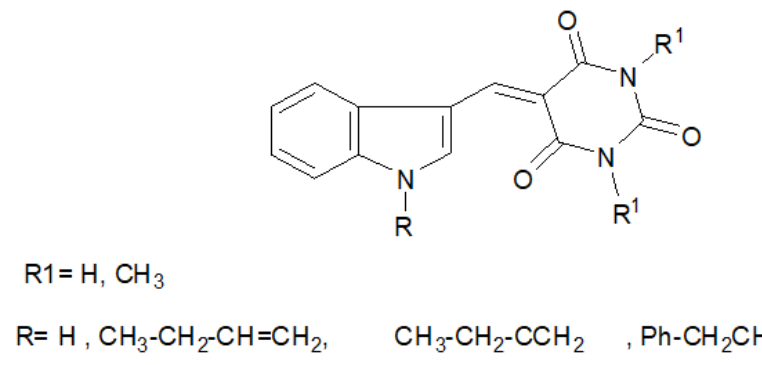
Fig. 6 . Barbituric acid derivatives as